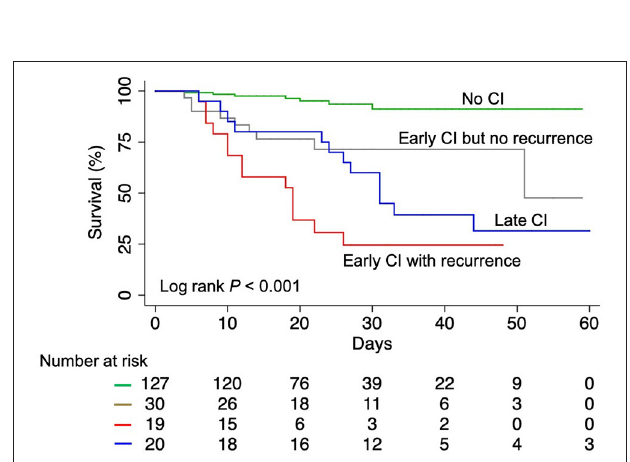
FIGURE 3 | Kaplan-Meier survival curves for COVID-19 patients. COVID-19, coronavirus disease 2019; CI, cardiac